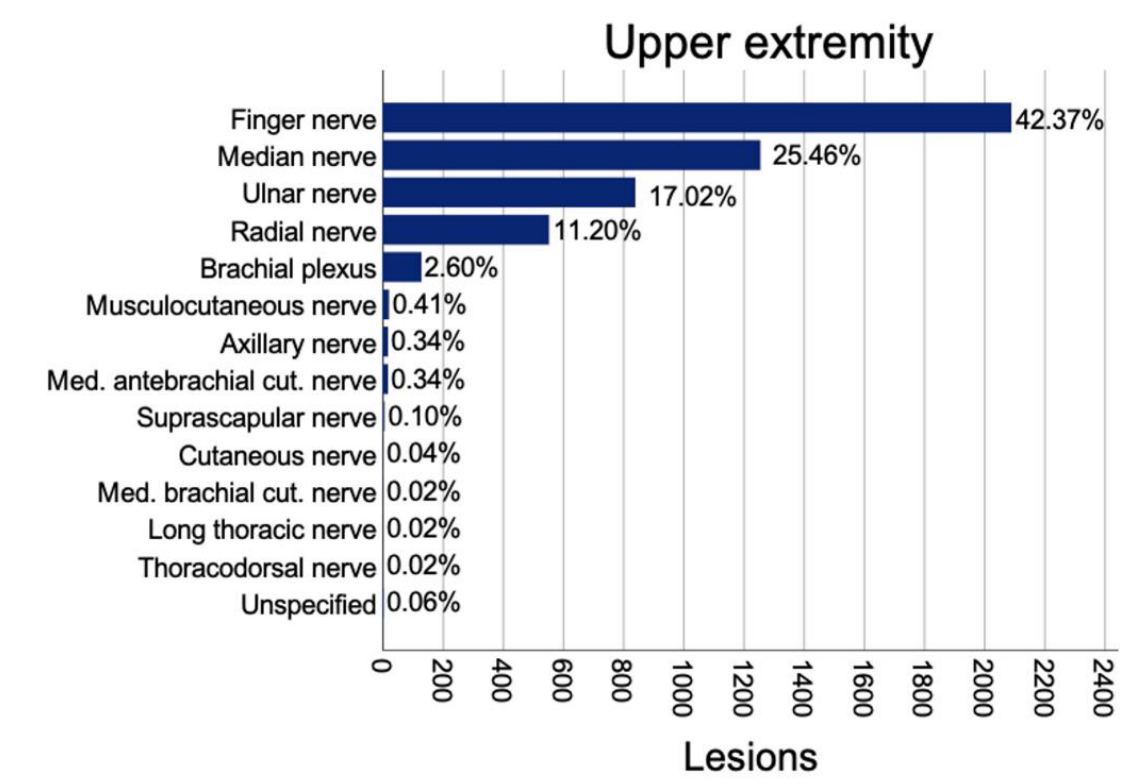
Figure 2. Prevalence of nerve lesions in the upper extremity.